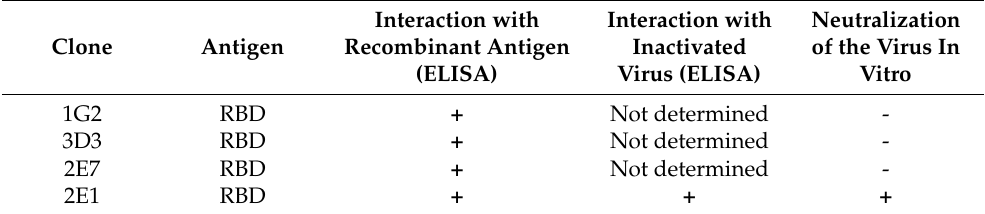
Table 1. Characterization of monoclonal